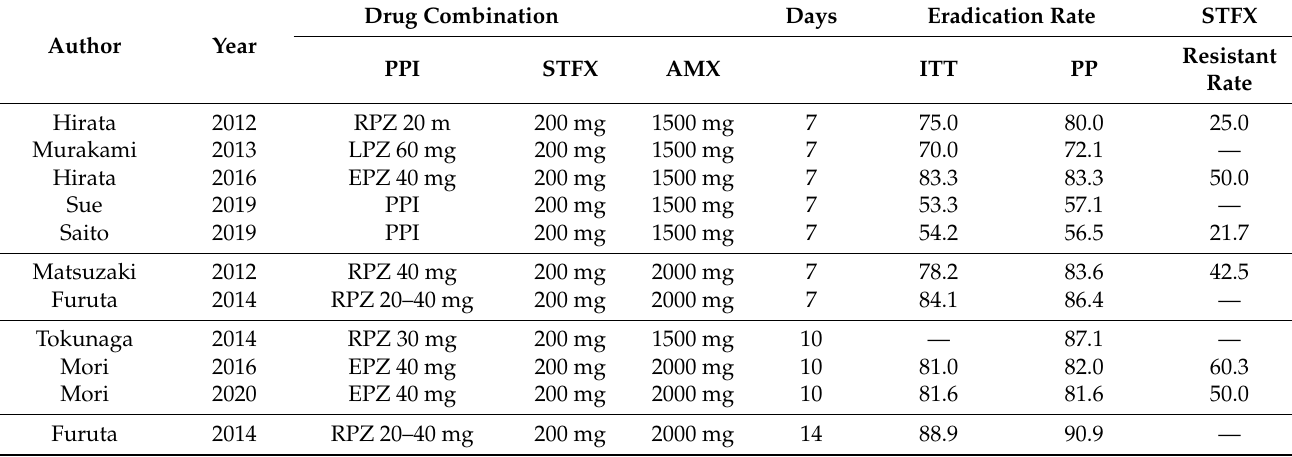
Table 1. Efficacy of PPI–sitafloxacin (STFX)–amoxicillin (AMX).